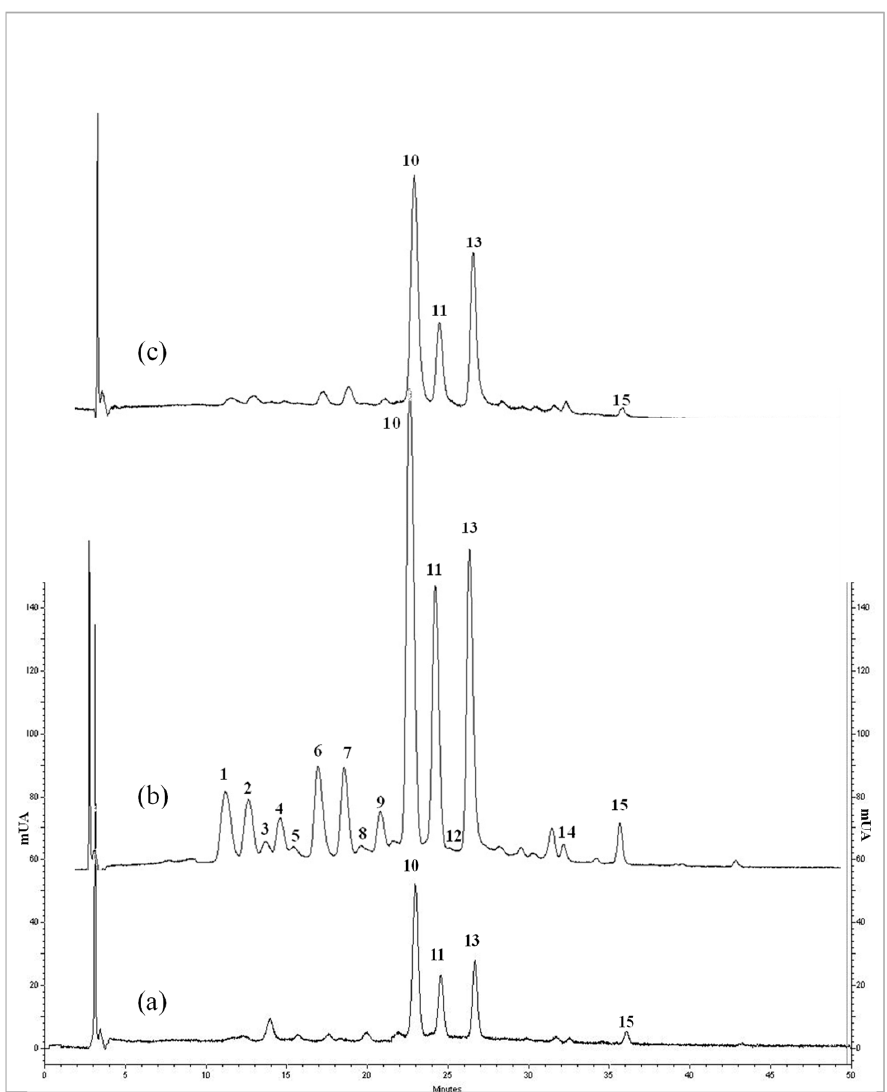
Figure 3. Chromatograms of the anthocyanins fraction corresponding to initial juice ( a ), partial fermentation wine (wine PF) ( b ) and total fermentation wine (wine TF) ( c ). Anthocyanins: 1. Dp-3-gal: Delphinidin-3-galactoside; 2. Dp-3-glc: Delphinidin-3-glucoside; 3. Cn-3-gal: Cyanidin-3-galactoside; 4. Dp-3-arb: Delphinidin-3-arabinoside; 5. Cn-3-glc: Cyanidin-3-glucoside; 6. Pt-3-gal: Petunidin-3-galactoside; 7. Cn-3-arb: Cyanidin-3-arabinoside; 8. Pn-3-gal: Peonidin-3-galactoside; 9. Pt-3-arb: Petunidin-3-arabinoside; 10. Mv-3-gal: Malvidin-3-galactoside; 11. Mv-3-glc: Malvidin-3-glucoside; 12. Pn-3-pentoside: Peonidin-3-pentoside; 13. Mv-3-arb: Malvidin-3-arabinoside; 14. Pn: peonidin 15. Mv: malvidin However, both wines presented different concentrations of phenolic compounds (Figure 4). Wine PF was partially fermented to 6.73% v / v , and the fermentation was stopped, adding wine alcohol to 12% v / v , obtaining a sweet wine with 92 g/L of residual sugars. This wine had an anthocyanin content three times higher and flavan-3-ol deriva- tives content 1.5 times higher than wine TF, which was fermented to consume the sugars by yeasts.